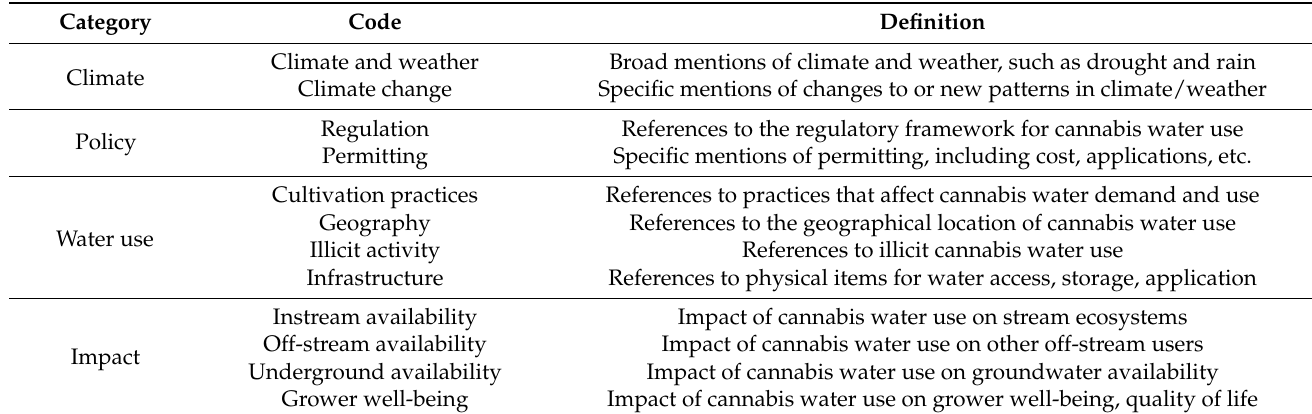
Table 2. Codes used within categories and their